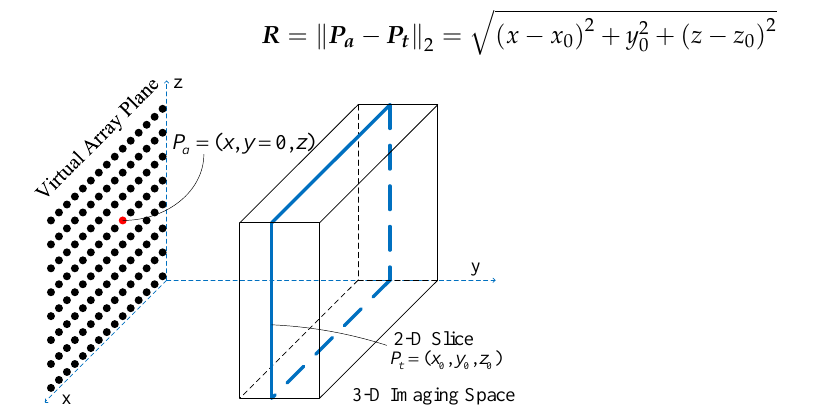
Figure 2. 3-D near-field radar imaging model.